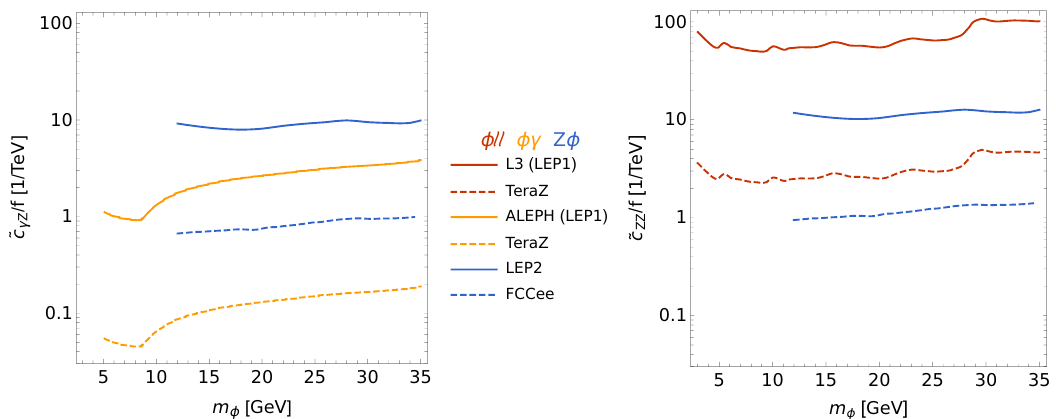
Figure 4 . Existing (solid) and projected (dashed) limits on the CP -odd coupling of the relaxion to (cid:13)Z (left) and ZZ (right) as a function of the relaxion mass: e + e (cid:0) ! Z(cid:30) (blue) at LEP2 [70] and FCCee. Additionally for ~ c (cid:13)Z =f : Z ! (cid:13)(cid:30) (orange) at ALEPH [93, 94] during LEP1 and at